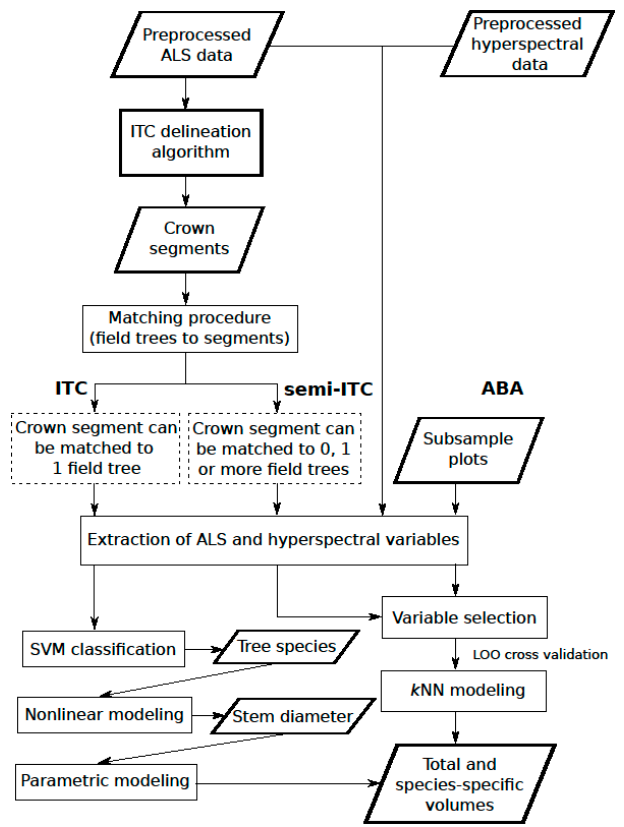
Figure 1. Flowchart of the procedure for predicting total and species-specific volumes.